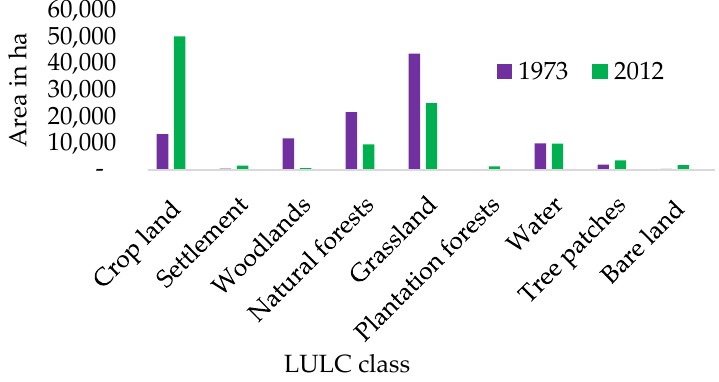
Figure 5. Changes in LULC from 1973 to 2012 in Munessa-Shashemene, Ethiopia (Source of data: Kindu et al. [1], but figure done by authors).